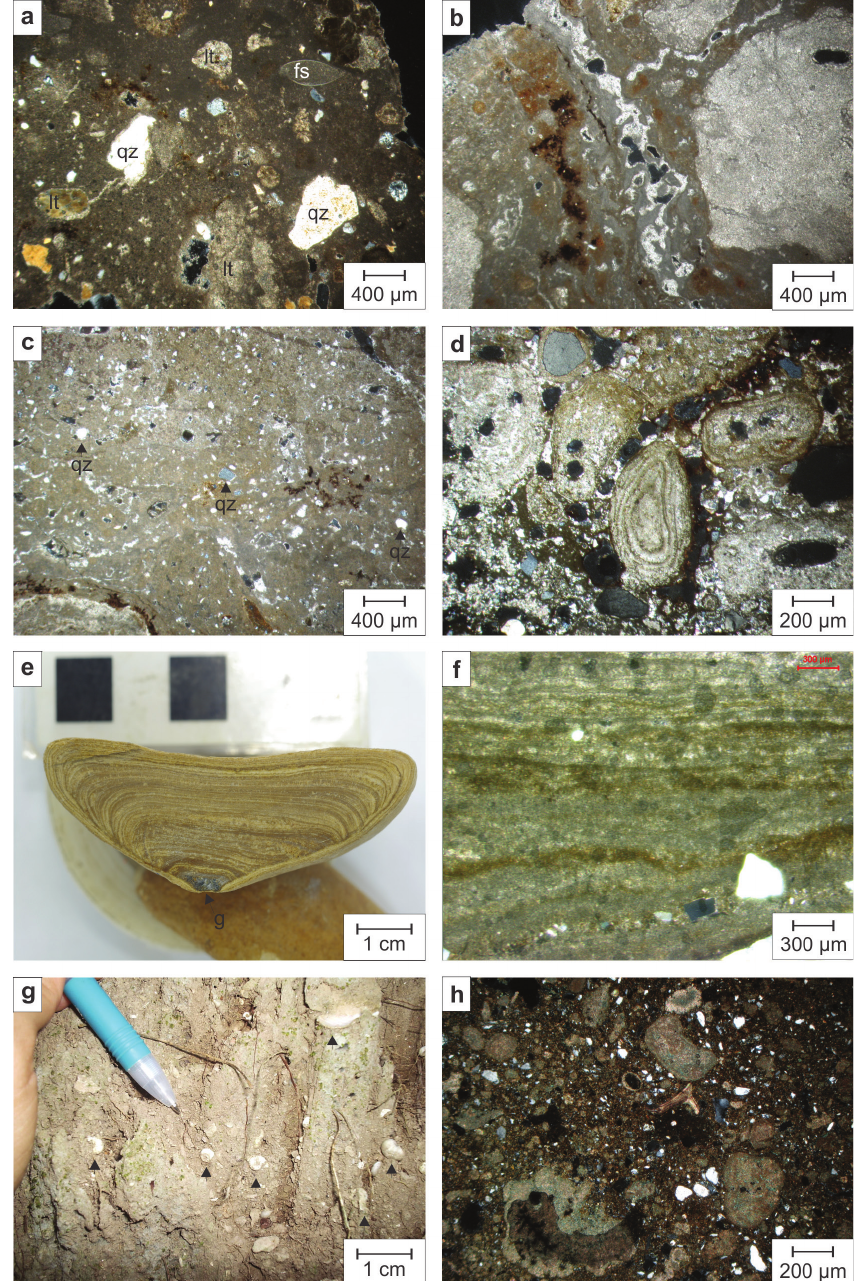
Figure 3 - Plate showing photographs and microscopic photographs (optical microscope) of lower facies. a : Microscopic photograph (polarized) of wackestone with fossils (calcrete), clasts are quartz (qz), lithics (lt) and fossils of ostracods (fs) (Corumbá, MS). b : Microscopic photograph (polarized) of wackestone with fossils (calcrete), root cavity (Corumbá/Ladário plateau). c : Microscopic photograph (polarized) of wackestone (calcrete), clasts are quartz (qz) and lithics (lt) (Serra das Araras). d : Microscopic photograph (polarized) of asymmetric coated grains with Fe cementation (Serra das Araras). e : Photograph of internal structures of an asymmetric oncolite with highlighted start up grain (g) (Serra da Bodoquena). f : Microscopic photograph (polarized) of asymmetric oncolite showing planar depositional structures (Serra da Bodoquena). g : Photograph of fossiliferous wackestone with gastropods fossils highlighted (arrows) (Serra da Bodoquena). h : Microscopic photograph (polarized) of low crystallized fossiliferous wackestone (Serra da